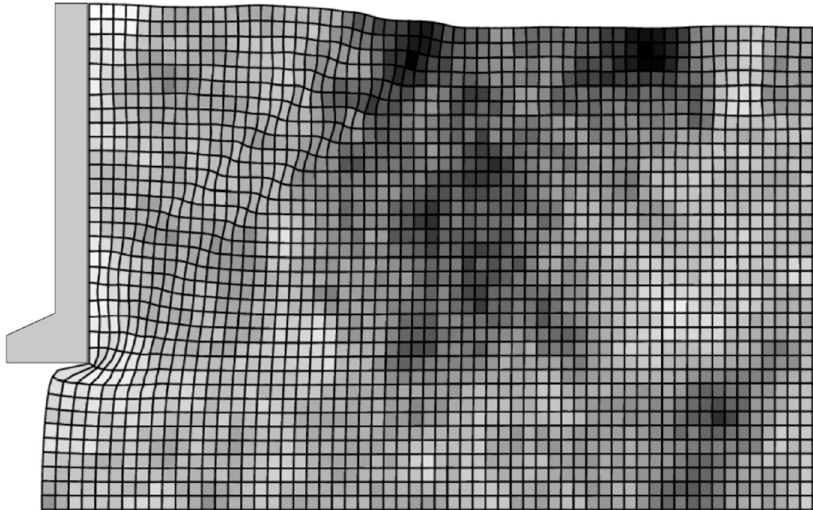
Figure 1. Figure illustrating the 60 (H) by 34 (V) finite element mesh considered with a random field of Figure 1 . Passive earth pressure failure of the “reference” wall. Figure illustrating the 60(H) by 34(V) φ (cid:48) mapped onto it; light areas correspond to lower friction angles. The mapped random field is for finite element mesh considered with a random field of ' φ mapped onto it; light areas correspond to θ / H = 8.3 and COV of φ (cid:48) = 0.3. The soil is in the passive lower friction angles. The mapped random field is for 8.3 H θ = and COV of ' φ = 0.3.